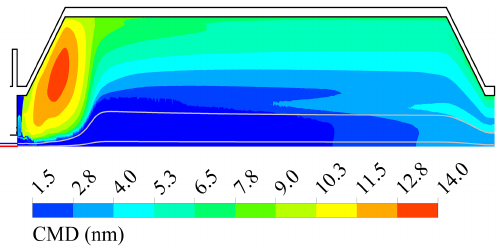
Figure 15. CMD in the aging chamber region when there is [ H ] = 4 . 6 × 10 10 cm − 3 in raw exhaust of A case with n sa = 1 2 SO 4 and when turbulent diffusion for particles is neglected. The path lines are also shown. The figure is scaled vertically with a factor of